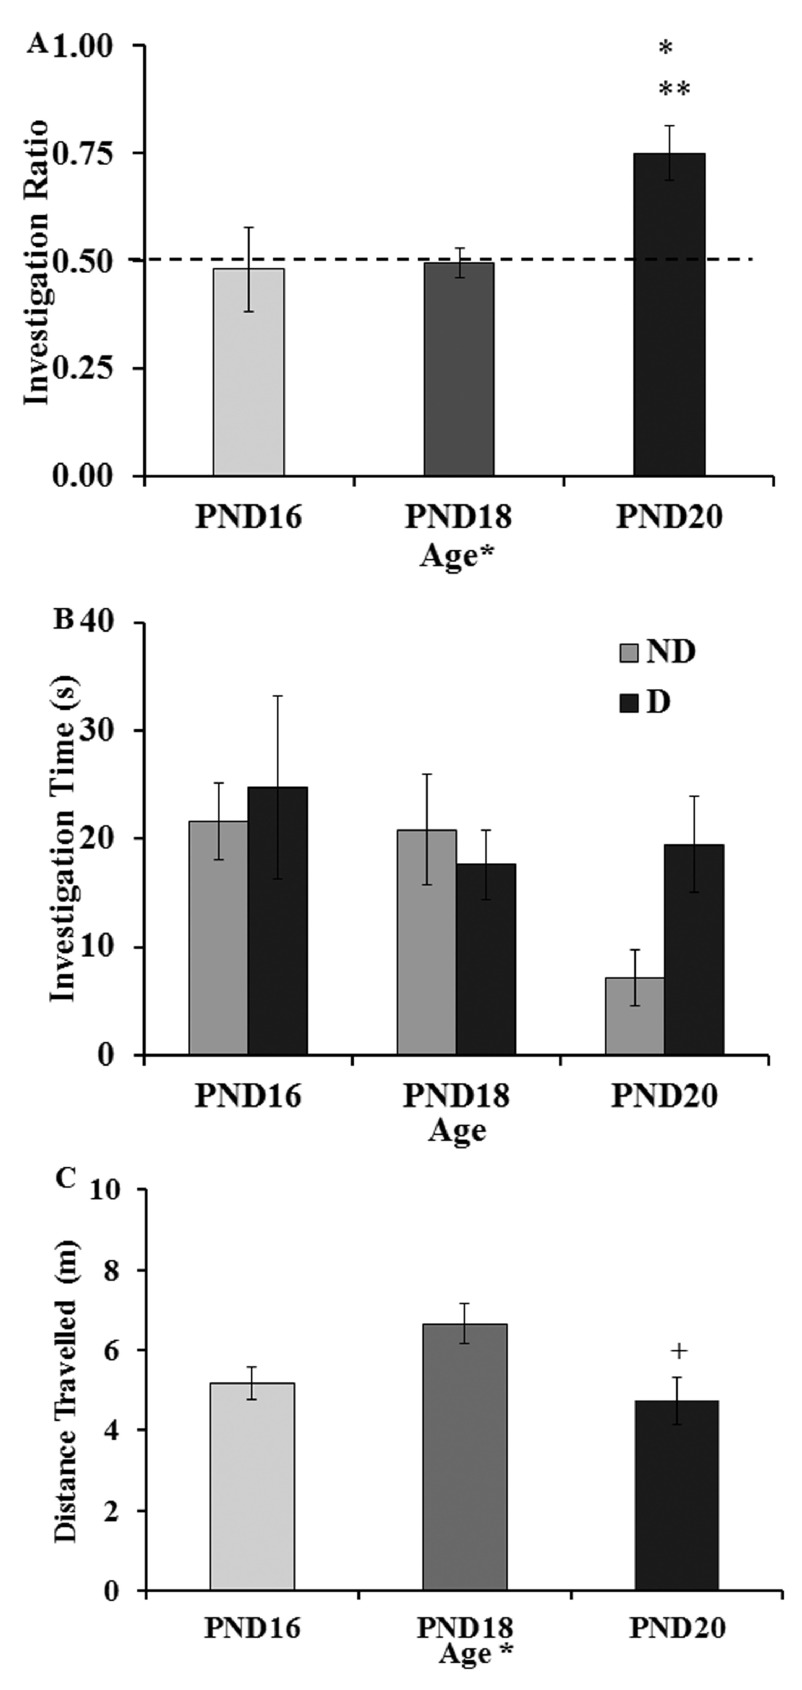
One-day object in a novel location task (ONL).Groups of rats were trained and tested on a single day: PND16, PND18 or PND20. (
A) Mean investigation ratios (± SEM) from the entire 5 minute test. Dotted line indicates chance investigation ratios meaning similar times spent investigating the displaced (D) and non-displaced (ND) objects. The PND20 group showed an investigation ratio significantly above chance (** p < 0.01) indicating a preference for the D object over the ND object. The PND20 group also showed a larger investigation ratio than the PND16 and PND18 groups (* p < 0.05). (
B) Average total time (seconds ± SEM) spent investigating the D and ND objects. There were no overall age effects or object effects on investigation time. (
C) Total distance traveled during the ONL 5 minute test. Data are expressed as average (± SEM) distance in meters. A main effect of age (*, p < 0.05) was found with the PND18 group showing a longer distance traveled than the PND20 group (+, p < 0.05).